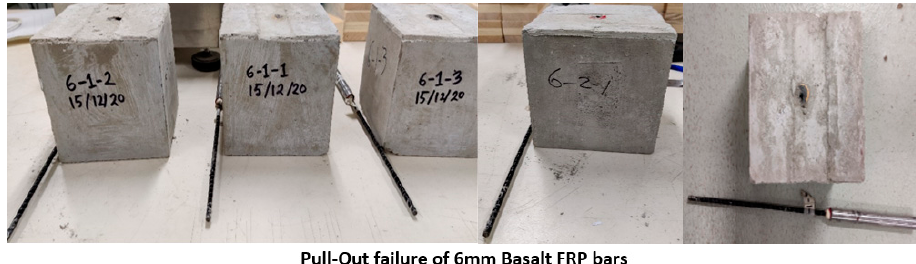
Figure 11 . Pull-out failure of 6-mm BFRP bar specimens. Figure 11. Pull-out failure of 6-mm BFRP bar